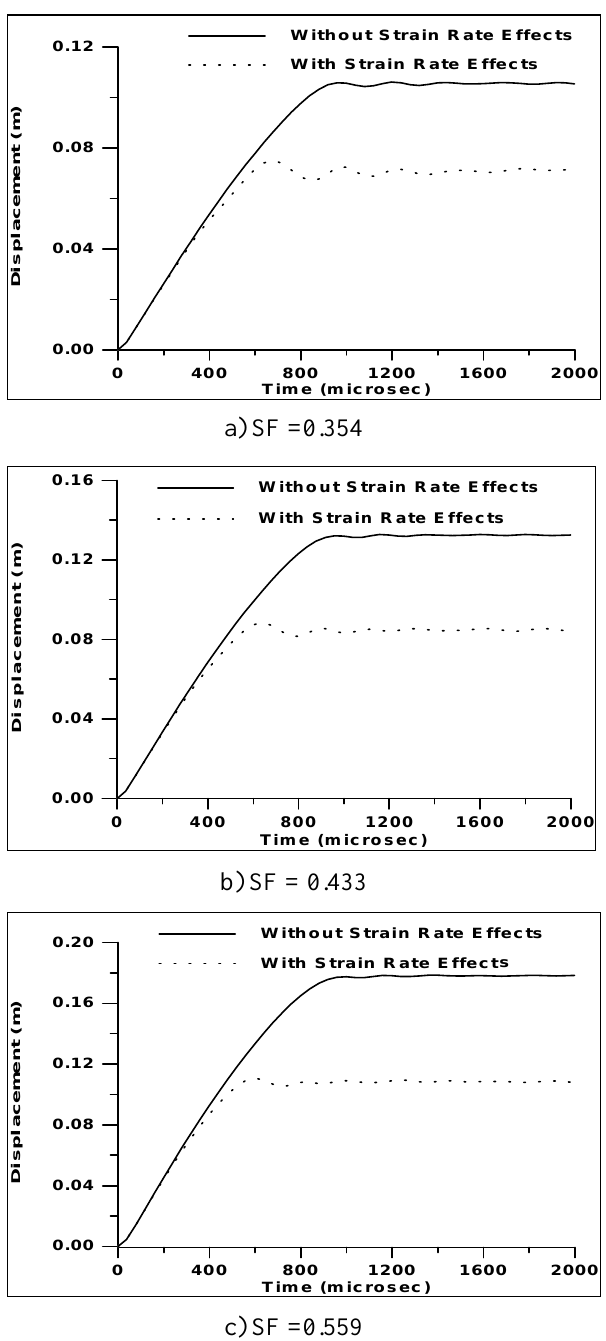
Fig. 10. Displacement time history for h/l = 0 . 05